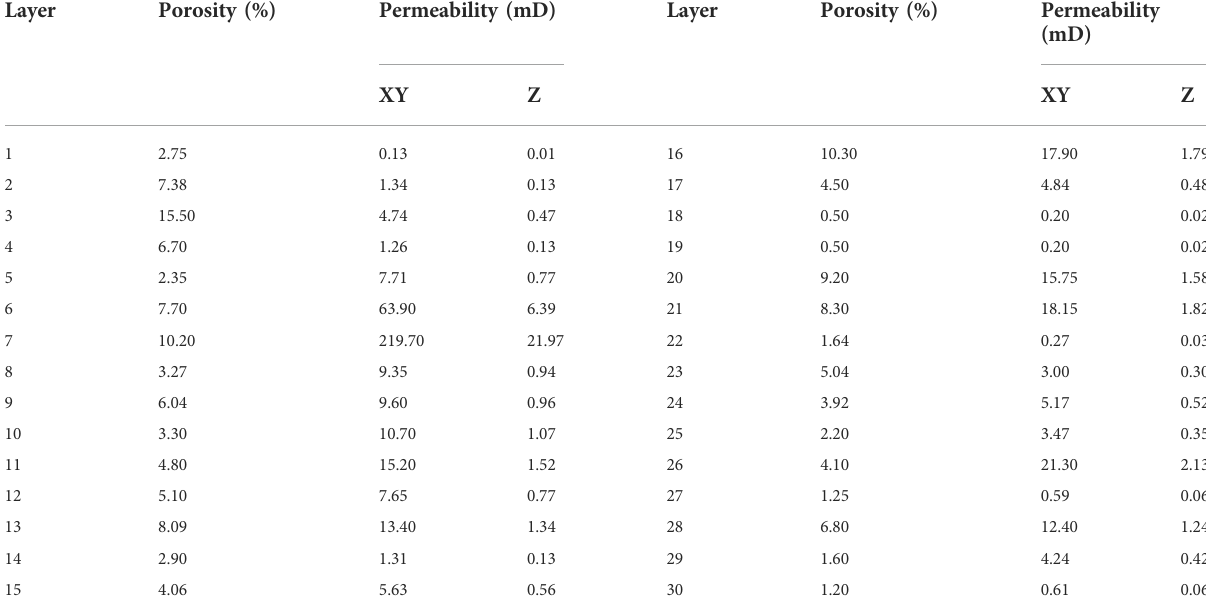
TABLE 6 The effective porosity and permeability parameters of layers.